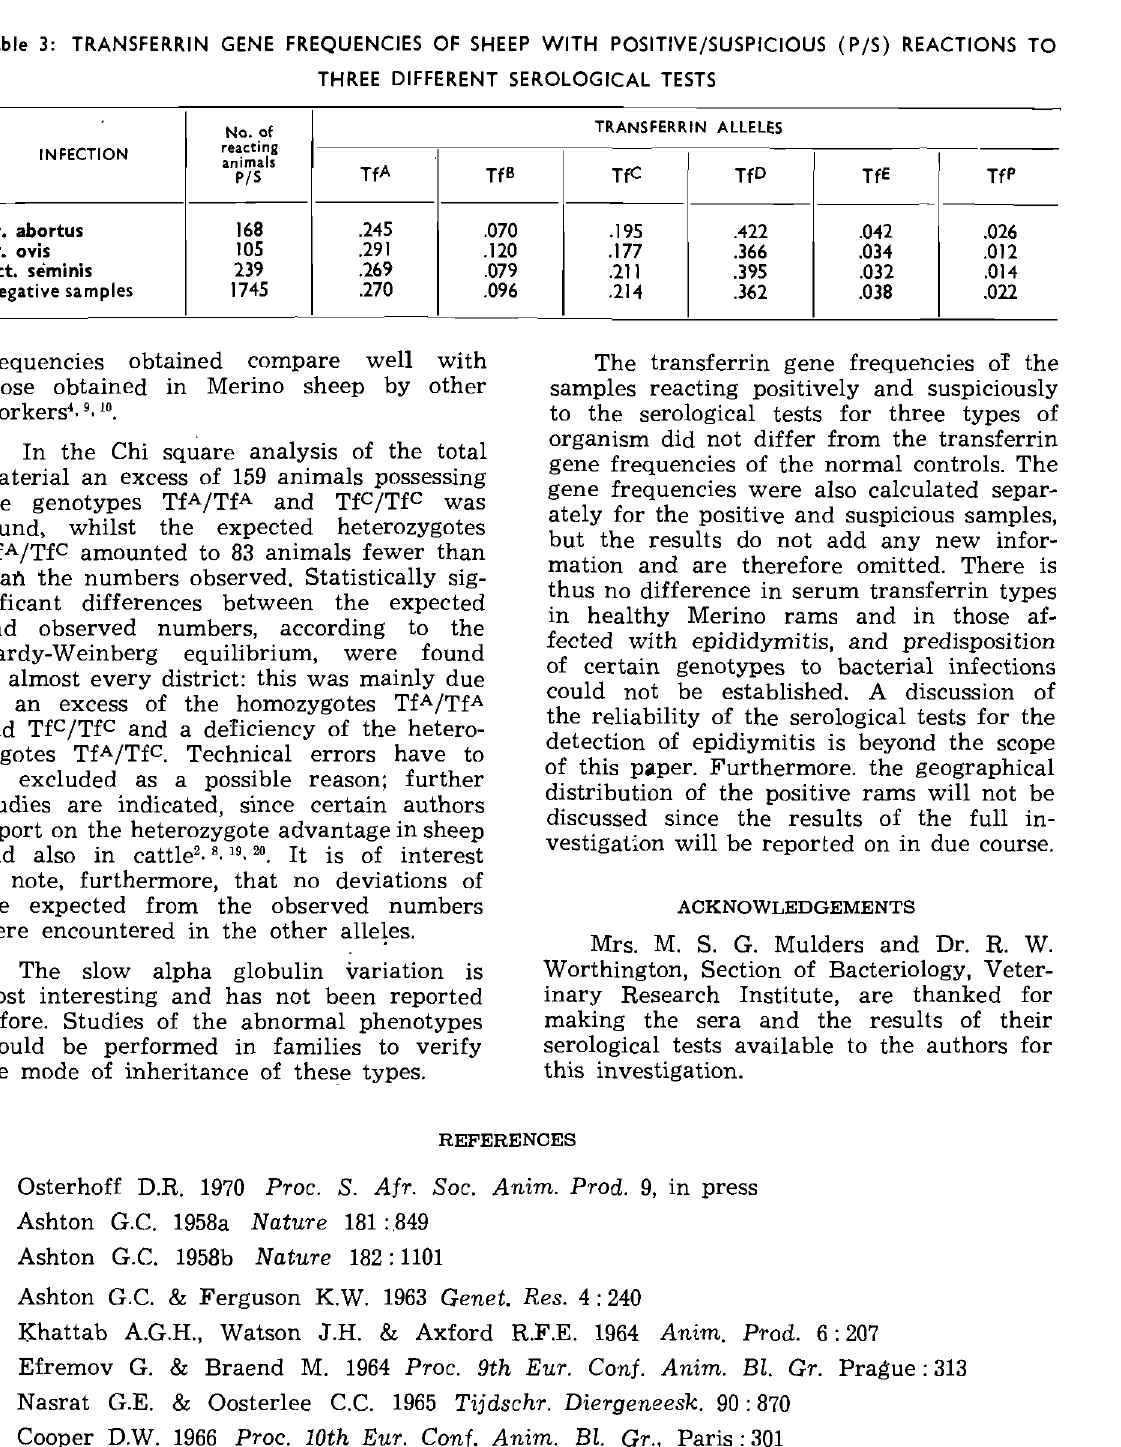
Table 3: TRANSFERRIN GENE FREQUENCIES OF SHEEP WITH POSITIVE/SUSPICIOUS (P/S) REACTIONS TO THREE DIFFERENT SEROLOGICAL